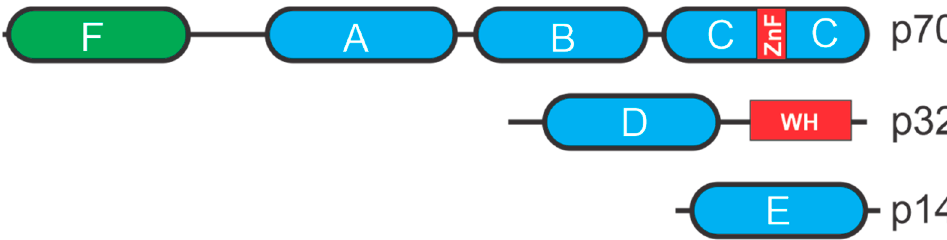
Figure 2. RPA structural motifs. OB-folds are depicted as ovals with other motifs depicted as rectangles. ZnF is a zing finger motif and WH a winged-helix motif.